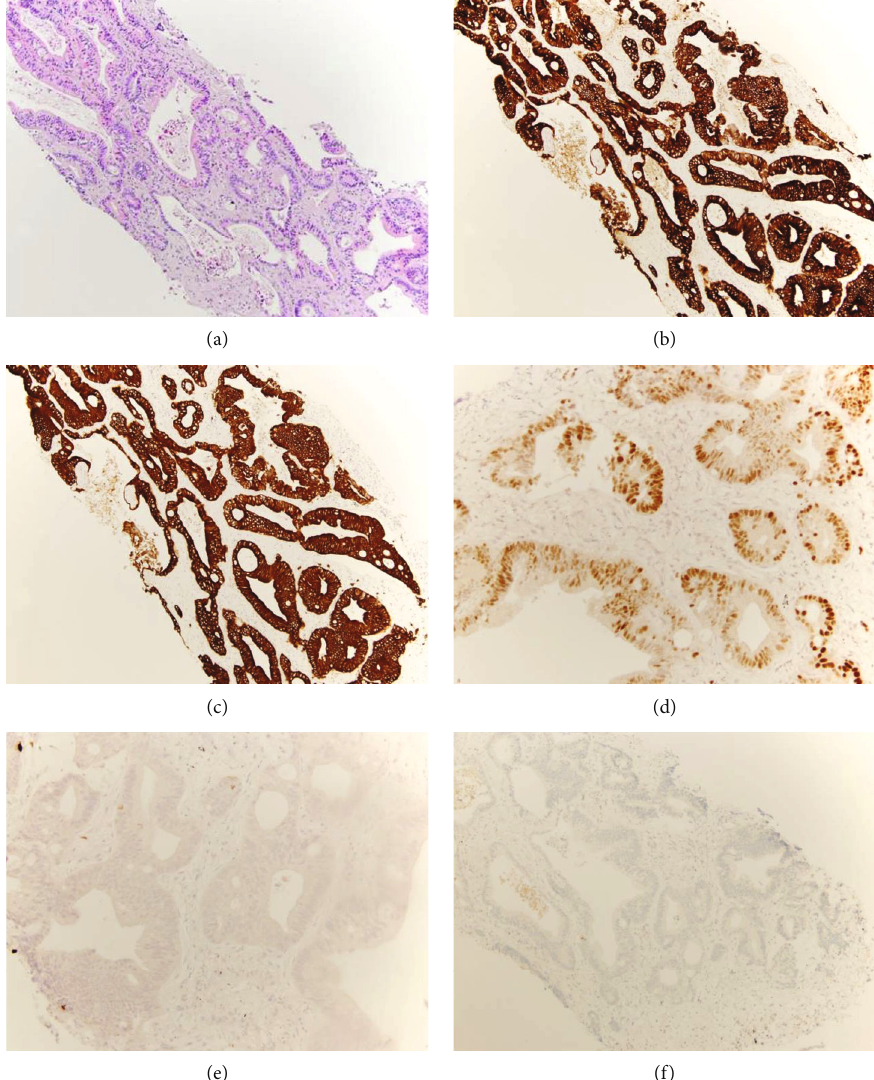
Figure 2: (a) Histologic sections of the needle core biopsy of a right lower lobe nodule demonstrated a proliferation of neoplastic glands with pseudostrati fi ed columnar epithelium and intraluminal mucin secretions, consistent with moderately di ff erentiated adenocarcinoma. Immunohistochemistry revealed positivity for cytokeratin 7 (CK7) (b), cytokeratin 20 (CK20) (c), and PAX-8 (d). Transcription termination factor-1 (TTF-1) (e) and estrogen receptor (ER) (f) were negative. Magni fi cations in (a) – (c) and (f) is 10x and in (d) and (e) is